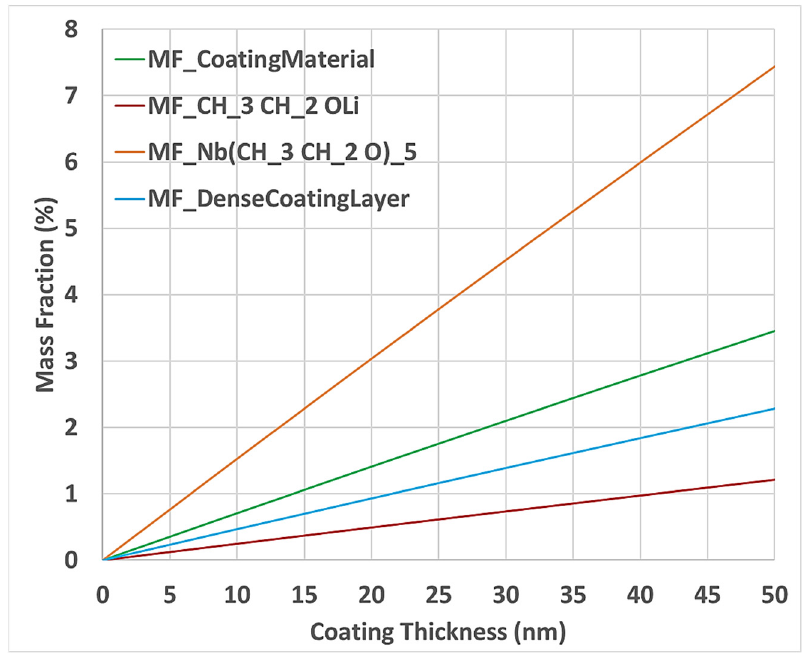
Figure 4. Mass fraction of initial materials to coat NMC-60 with the desired thickness of LNO.